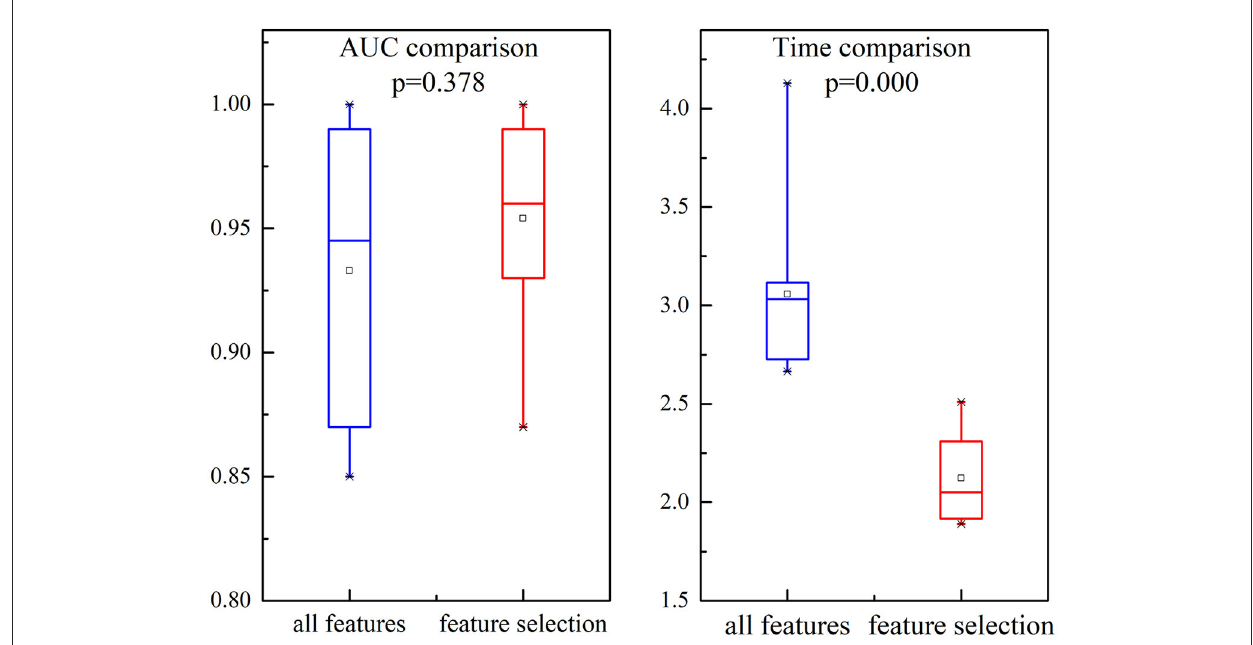
FIGURE9 Illustration of the comparison for AUC and time in all features and selected features. Each box represents the 25–75th percentiles, the central line is the median value, and the tiny vertical lines extend to the most extreme data not considered outliers, which are plotted individually.